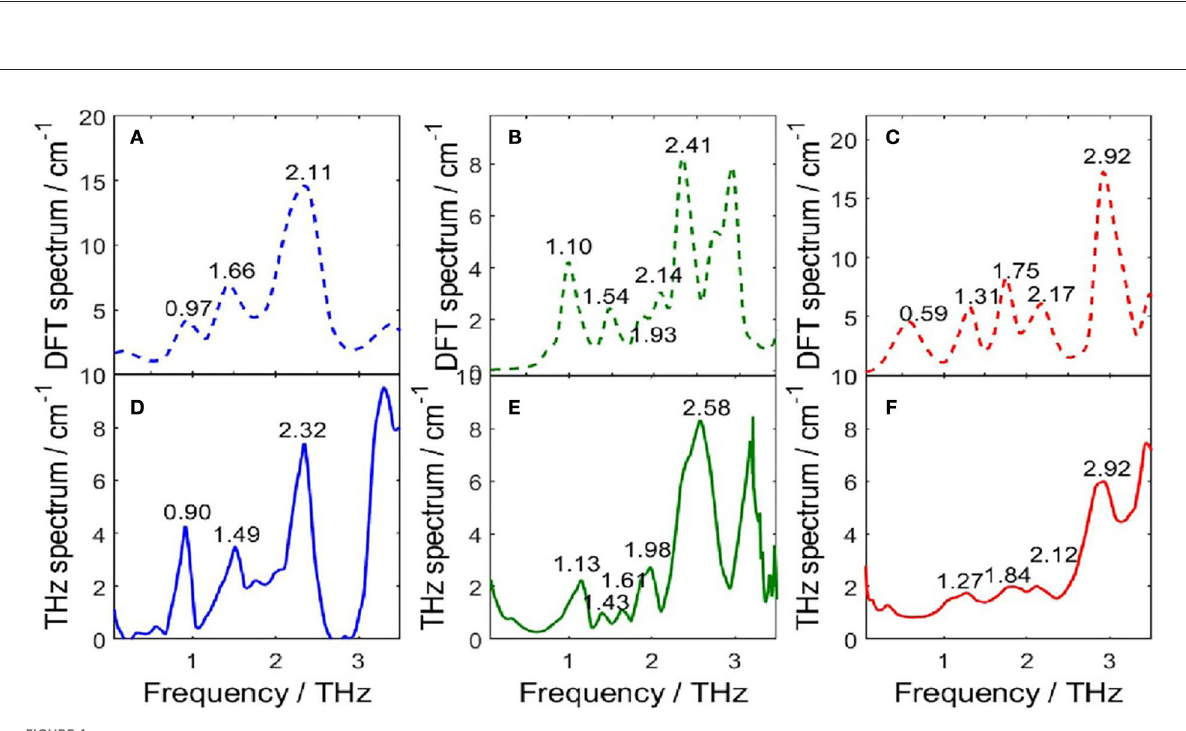
FIGURE4 Comparison of experimental and theoretical spectra of three pyrethroid pesticides. (A–C) Density functional theory (DFT) spectrum of deltamethrin, fenvalerate and beta-cypermethrin, respectively. (D–F) THz spectrum of deltamethrin, fenvalerate, and beta-cypermethrin